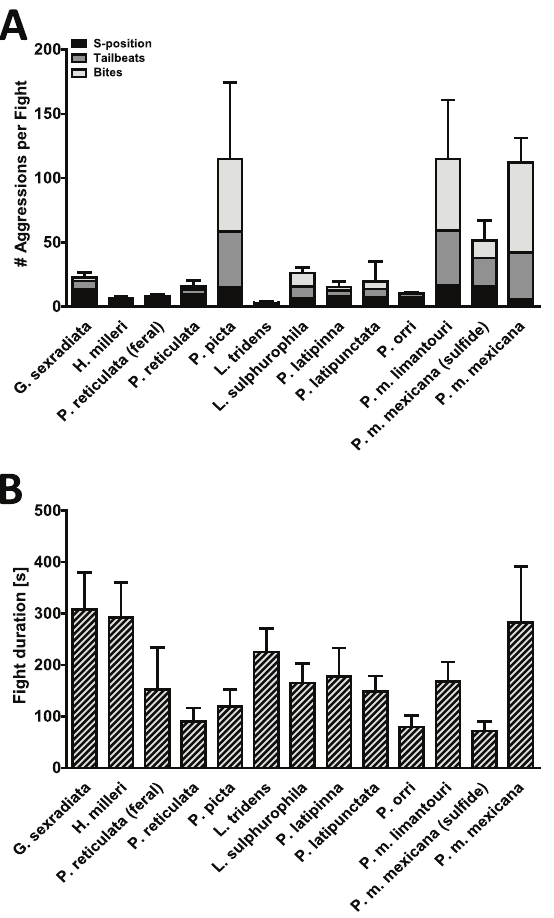
Figure 1. Means (± SE) of ( a ) numbers of aggressive interactions per male fight and ( b ) fight duration in the different poeciliid species examined . Table 3. Pair-wise Spearman’s rank order correlations between species-wise mean values for all seven behaviors investigated. An asterisk indicates significant correlations.